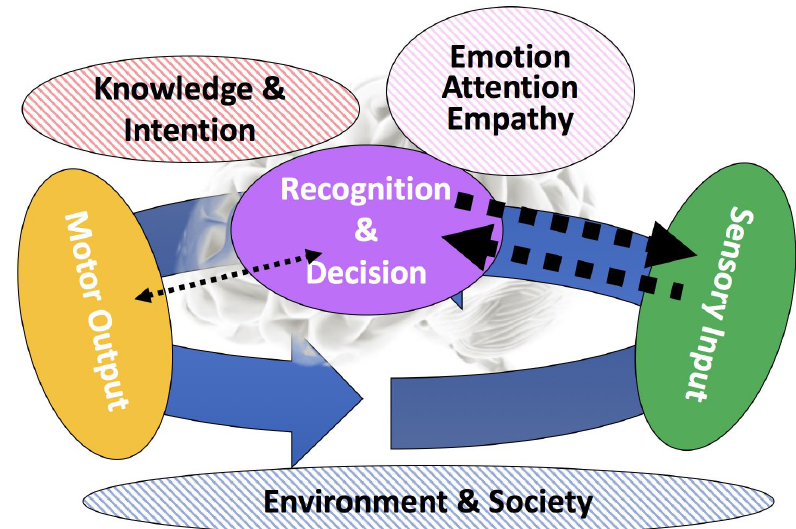
Figure 1. The current status of deep learning.